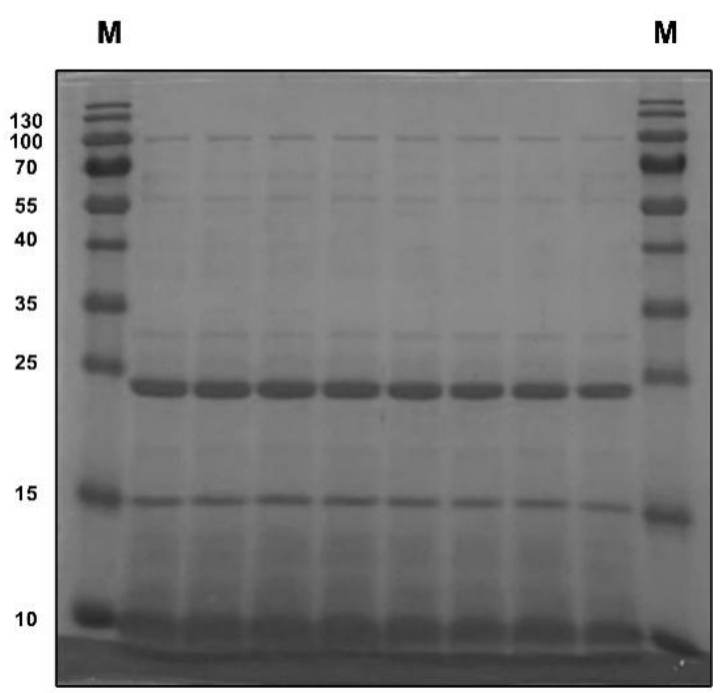
Figure 1. Sodium dodecyl sulfate–polyacrylamide gel electrophoresis for pea albumin.